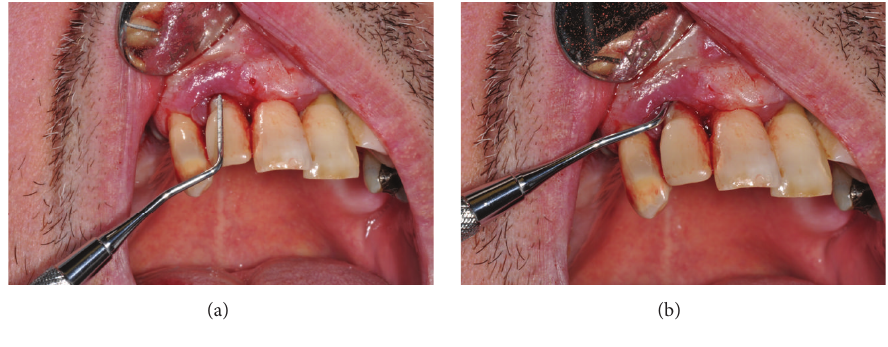
Figure 2: (a, b) Peri-implant probing.